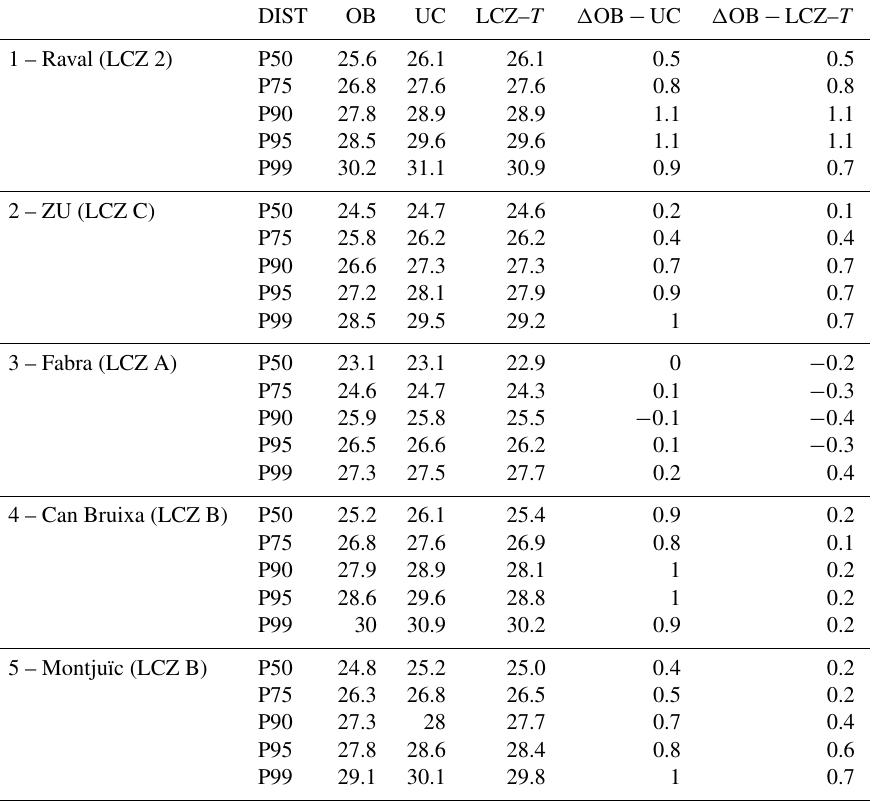
Table 5. Temperature for each distribution scenario (DIST) and weather station observed (OB), modelled by UrbClim (UC) and estimated from the distribution of temperature (the mean value is taken) for each LCZ (LCZ– T ). The difference ( (cid:49) ) between them is also shown. All the values are expressed in degrees Celsius. ZU denotes Zona Universitària.